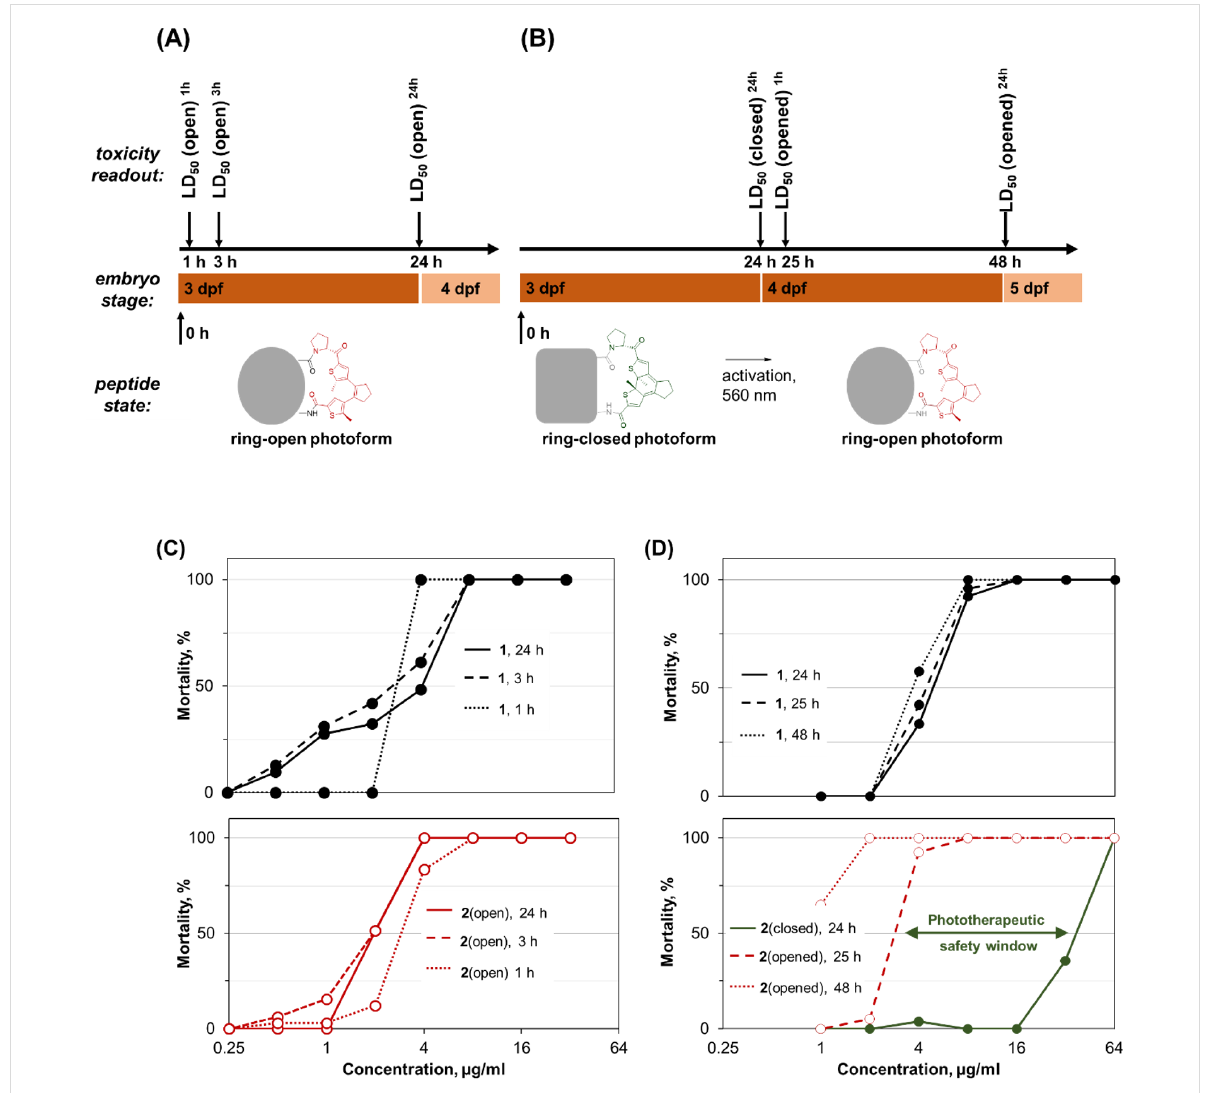
Figure 2: Two versions of the D. rerio embryotoxicity assay for DAE-modified peptides: timelines, peptide photostates, ages of larvae, and definitions of the measured characteristics. (A) Direct application of the non-photoswitchable parent GS 1 or of the ring-open photoform of our prototype 2 , and the corresponding killing curves for 1 (C, top, black) and 2 (C, bottom, red). (B) “Photoactivation” assay: initial application of the ring-closed photoform, incubation in darkness, followed by in situ photoconversion into the ring-open(ed) photoform, with the corresponding killing curves for 1 (D, top) and 2 (D, bottom, green for ring-closed, red for ring-open isomers). The latter panel illustrates the “phototherapeutic safety window” (green arrow) as the difference in toxicity between the ring-closed and the ring-open isomers upon photoactivation.